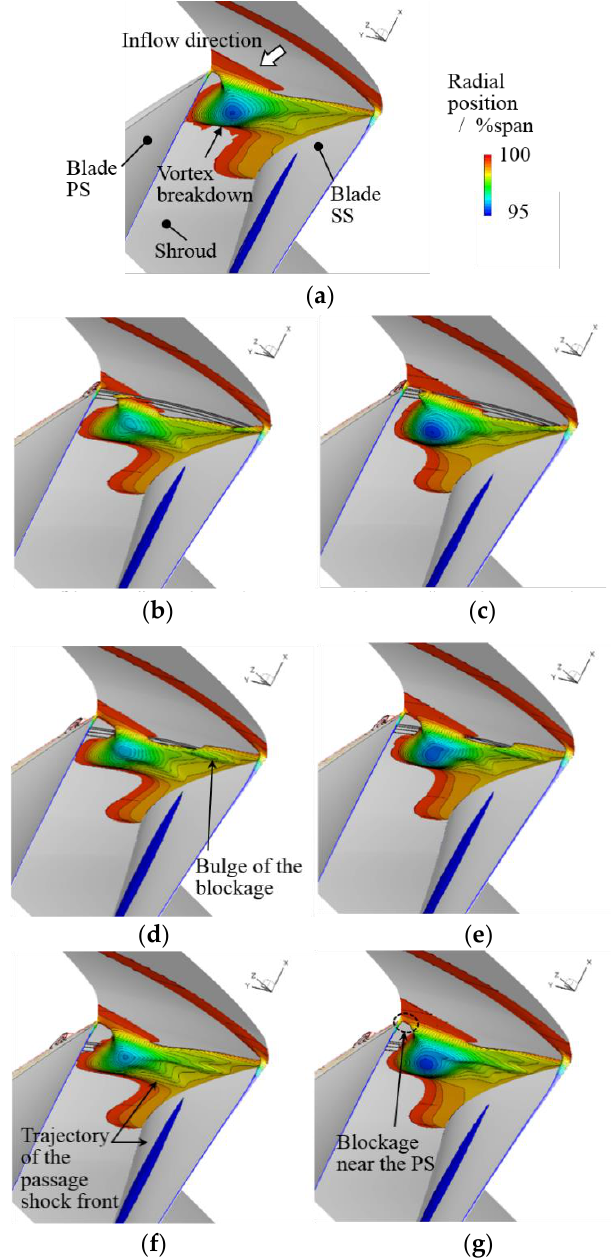
Figure 11. Visualization of the flow blockage mitigation on the shroud surface by the RC for different RC axial locations. Passage viewed from the hub towards the casing approximately in the radial direction. ( a ) BL (OP-A, NS). ( b ) Case #1.-1 (OP-A). ( c ) Case #1.-1 (OP-B, NS). ( d ) Case #0 (OP-A). ( e ) Case #0 (OP-B). ( f ) Case #1.1 (OP-A). ( g ) Case #1.1 (OP-B, NS).